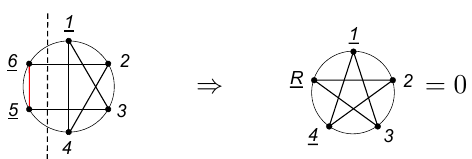
Figure 24 . Resulting graph from the factorization contribution of I (1) . The five-point diagram